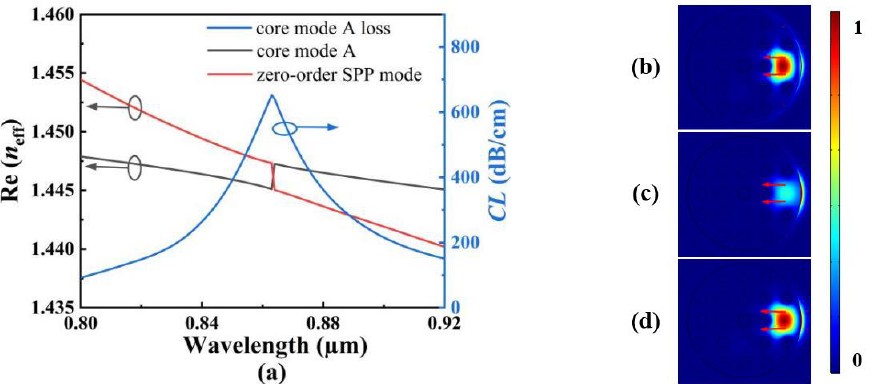
Figure 2. ( a ) The CL spectra of the core mode A, and the effective RI real parts of the core mode A and zero-order SPP mode when the analyte RI is chosen as 1.40. ( b – d ) The mode field distributions of the core mode A and zero-order SPP mode calculated at wavelengths 0.82, 0.863, and 0.9 μ m,